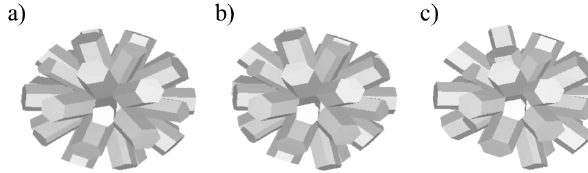
Fig. 6. Droxtals with (a) θ 1 = 32 . 35 ◦ and θ 2 = 71 . 81 ◦ , (b) θ 1 = 10 . 00 ◦ and θ 2 = 80 . 00 ◦ , and (c) θ 1 = 1 . 5 ◦ and θ 2 = 85 . 0 ◦ . The D for each droxtal is 50µm and the corresponding area ratios are (a) 0.85, (b) 0.77, and (c) 0.69.